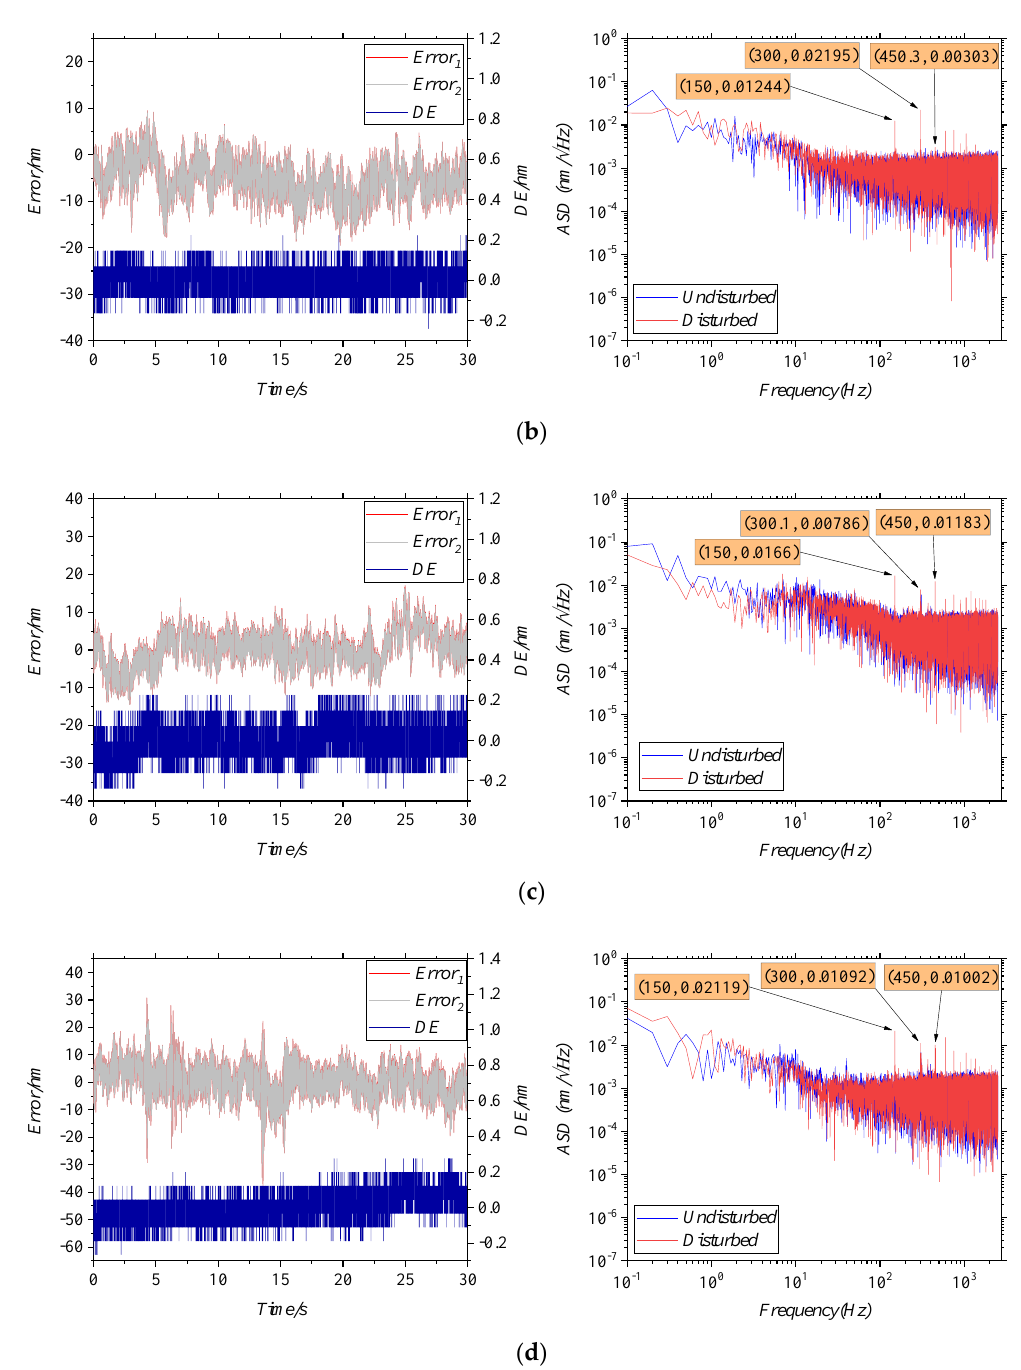
Figure 7. The errors curves for changing the irradiance ratio, ( a ) I AC /I DC = 100%, ( b ) I AC /I DC = 84%, ( c ) I AC /I DC = 77%, ( d ) I AC /I DC = 54%.